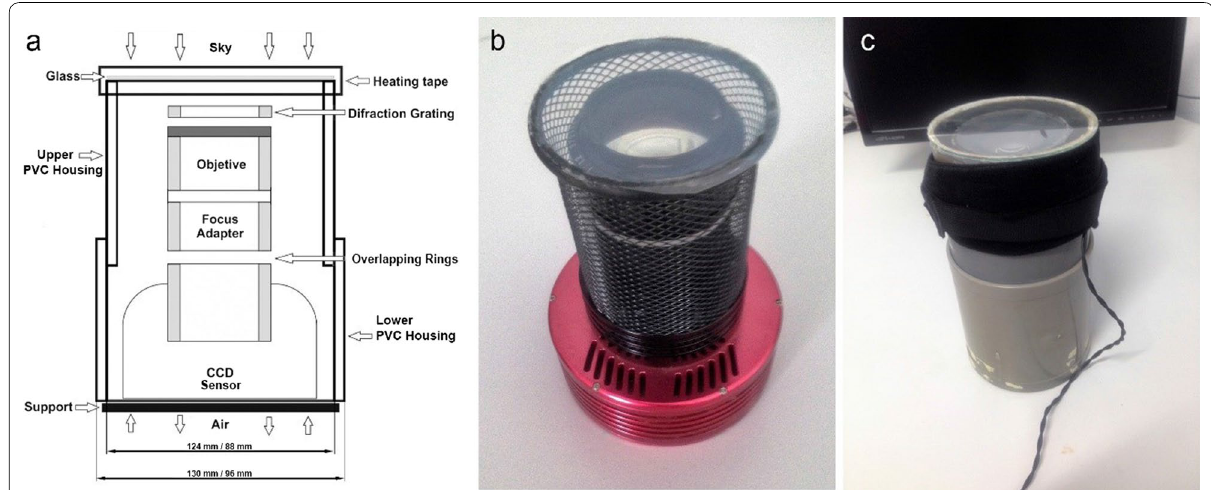
Fig. 1 Spectrograph. The two spectrographs have the same design and different size a layout and dimensions. b Spectrograph without protec‑ tions, c full